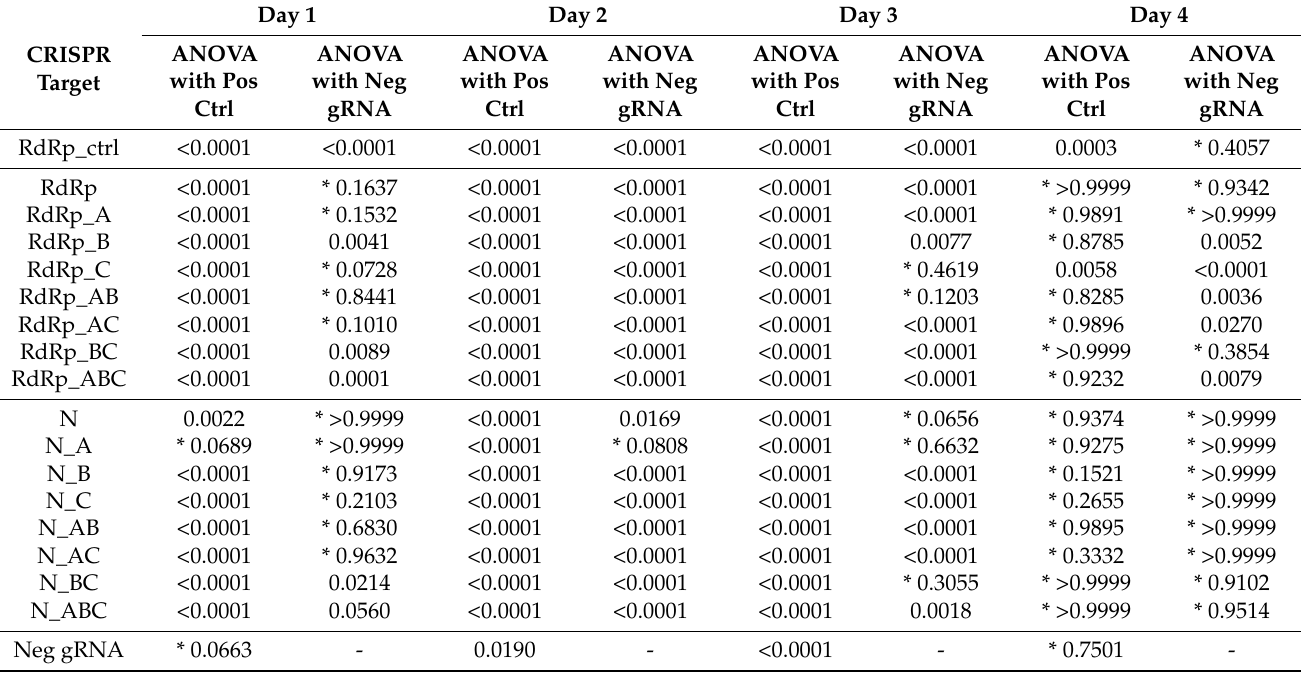
Figure 5. Percent reduction of HCoV-OC43 RNA for each gRNA over time. Data presented as the mean of triplicate replicates with error bars representing the standard error. Table 6. One-way ANOVA comparison of gRNA with positive control and negative gRNA. p values with an asterisk indicate the percent reduction is not significantly different from that of the HCoV- OC43 control or negative gRNA.